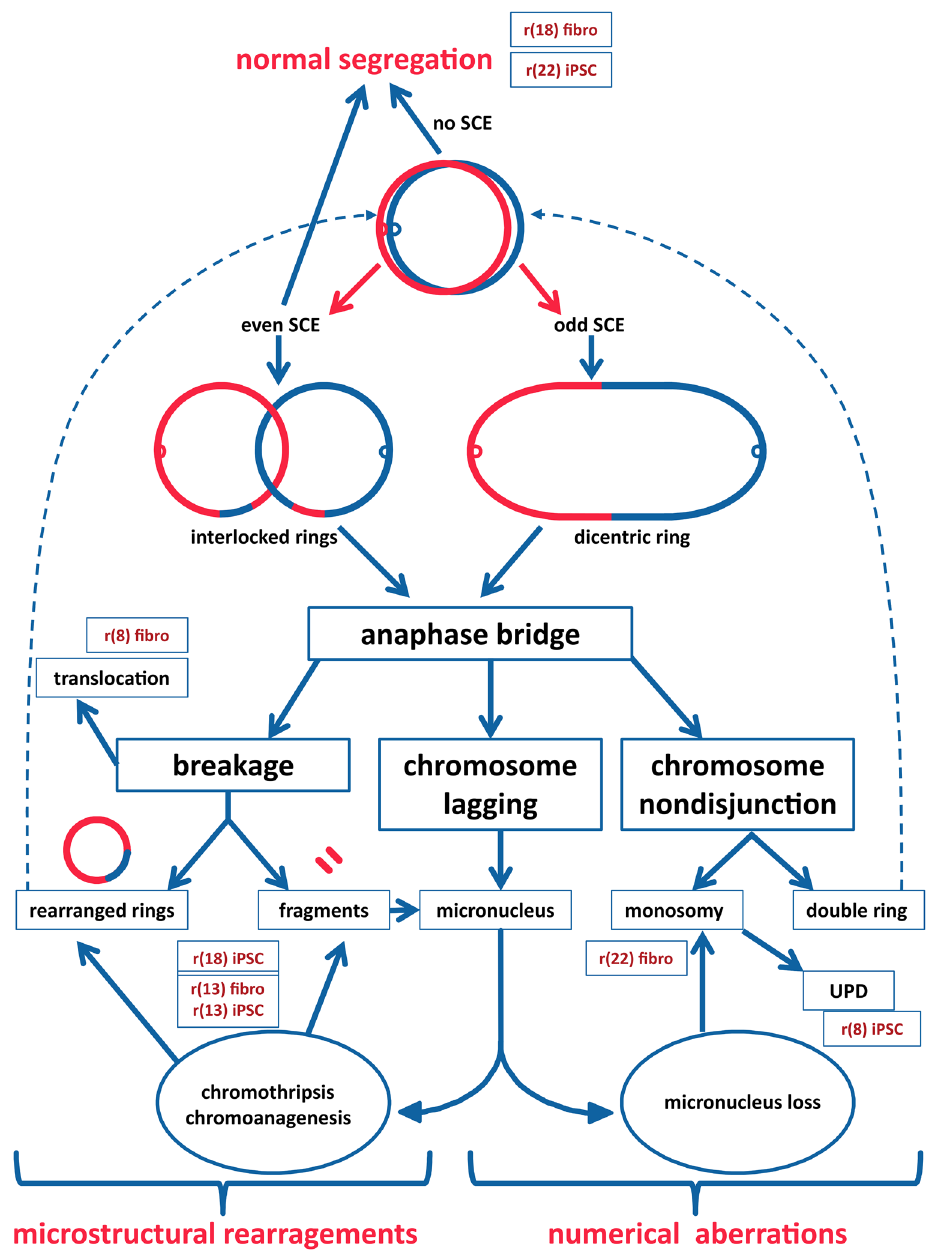
Figure 5. Hypothetical routes of ring chromosome mitotic instability. Possible mechanisms of the ring “behaviour” and formation of various ring derivatives found in this study for ring chromosomes 8, 13, 18, 22 in fibroblasts and iPSC cultures. If a ring chromosome replicates without SCE (no SCE) in prophase, the ring chromatids separate equally at anaphase, resulting in normal segregation to the daughter cells. One SCE (or an odd number of SCEs) causes the two daughter chromatids to form a dicentric double-sized ring. Two SCEs (or an even number of SCEs) would result in either normal segregation or the formation of interlocked rings. Dicentric rings and interlocked rings can form anaphase bridges at cell division with subsequent possible asymmetric breakage leading to unbalanced products or chromosome non-disjunction, resulting in the production of cells without a ring/with multiple rings. When a ring chromosome undergoes anaphase lagging, a micronucleus can form with either subsequent loss (resulting in monosomy) or reunion and chromothripsis (resulting in multiple rearrangements). As a result, numerical aberrations, microstructural rearrangements or normal segregation can be found. Obviously, combinations of different events can occur in a single cell line (and even in a single cell), so we present the names of the cell lines at the positions where the effect is observed more frequently. Dashed line arrows: passage to the next cell